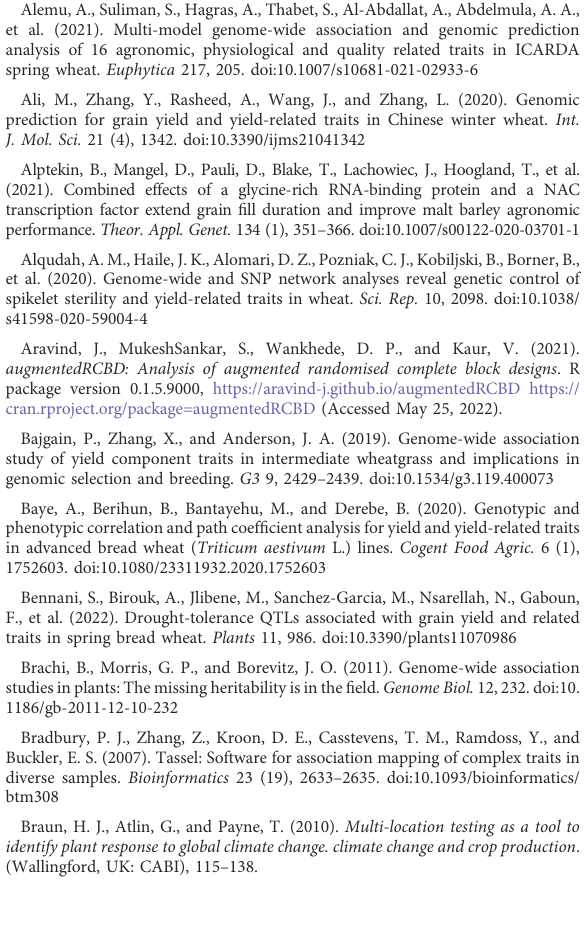
SUPPLEMENTARY TABLE 1 List of 280 genotypes used in the study along with pedigree and other details are given as Supplementary Table